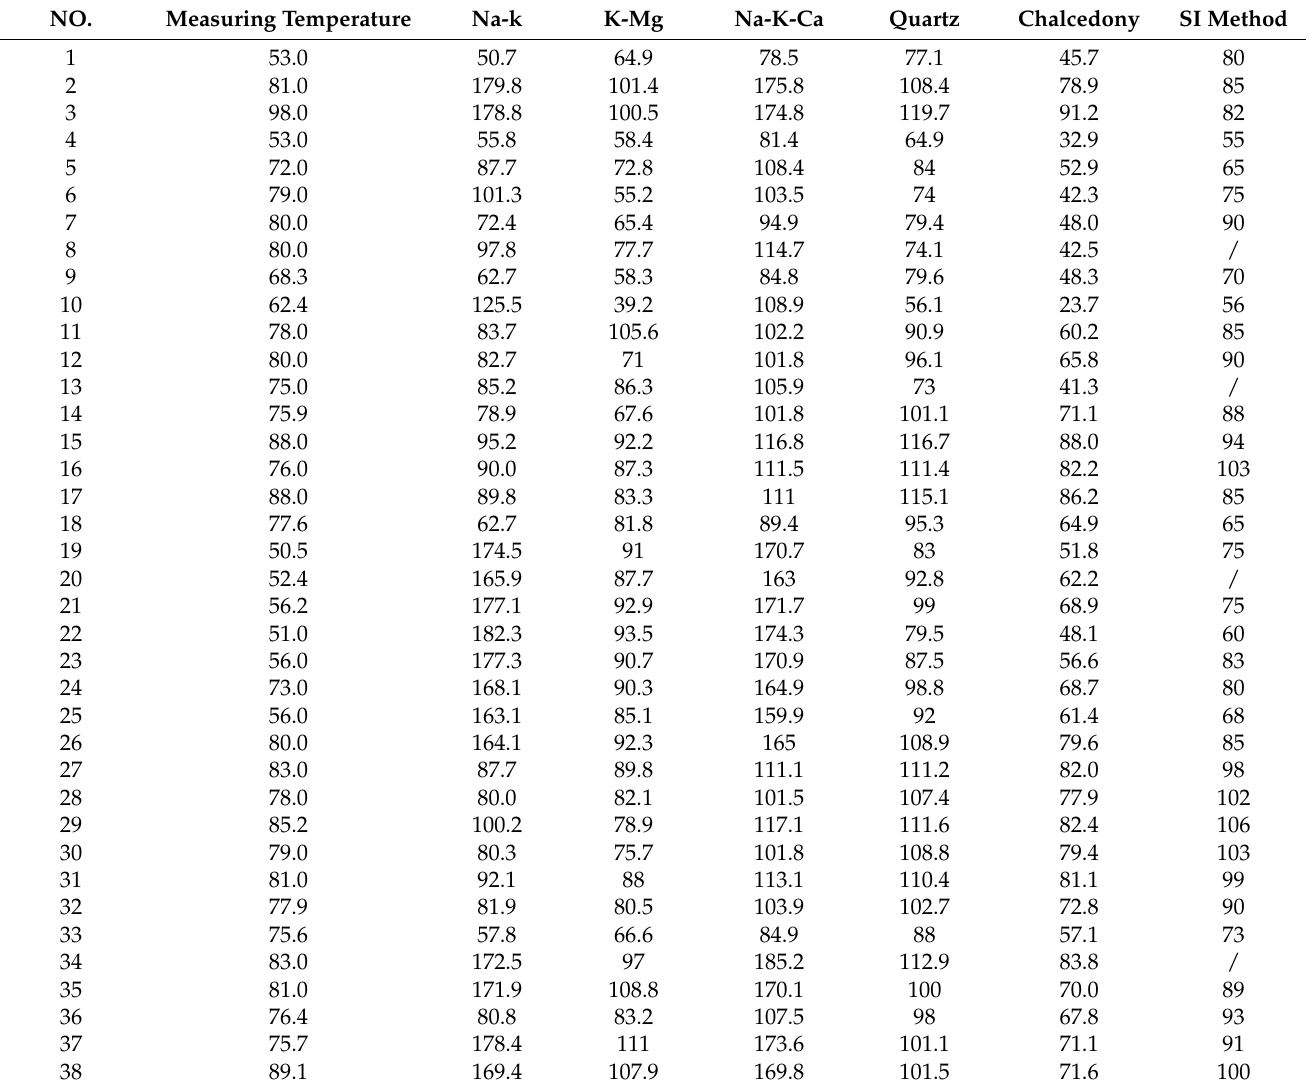
Table 2. Measured temperatures and geothermometer estimates ( ◦ C).